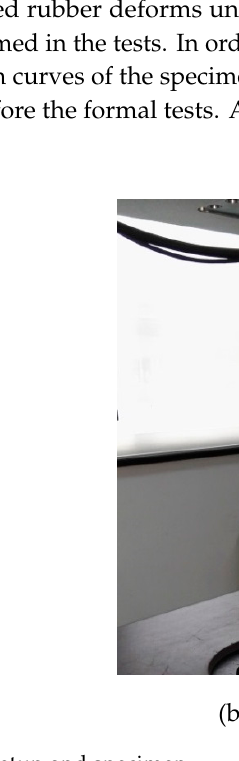
Figure 7. Test setup and specimen.